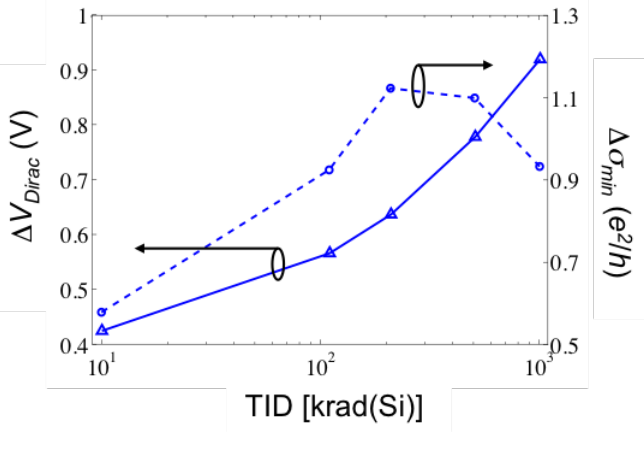
Figure 4. Shifts in the Dirac voltage (Δ V (Δ σ = σ − σ ) obtained for V min min min 0 4.7 e 2 / h ( e = 1.6 × 10 19 C, h = 6.63 × 10 −34